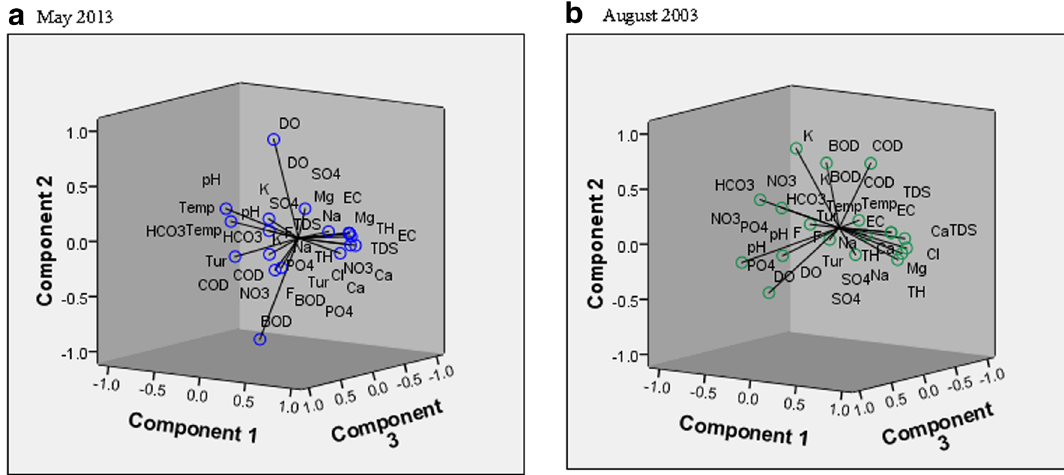
Fig. 9 a , b Rotated loadings for components 1, 2, and 3 (May 2013–August